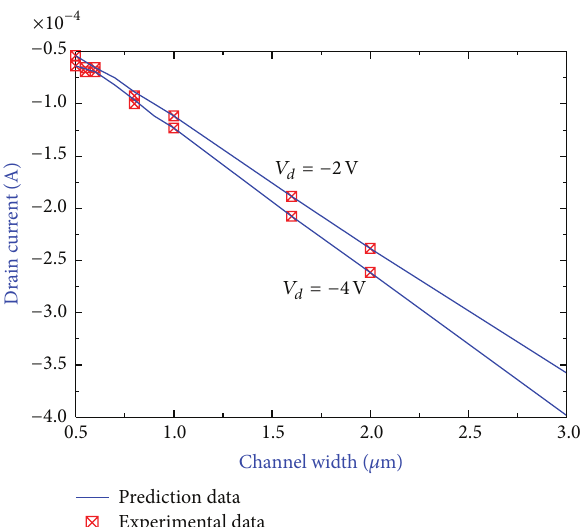
Figure 12: Comparison of 𝐼 𝑑 measured results and prediction data of the group 2A samples (as 𝑉 𝑑 = −2 , − 4V, 𝑉 𝑔 = −3 V).